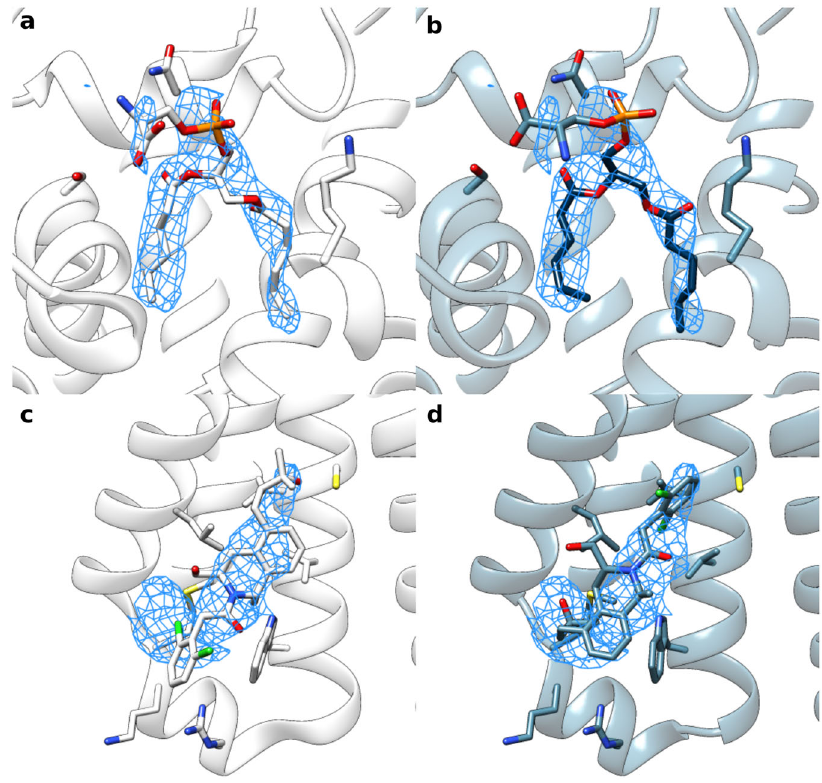
fi nd the same lipid tail orientations (dark blue). c The deposited model of LY3154207bound to DRD1 (EMDB: 30395, PDB: 7CKZ, localresolution: 3.09Å) and EMERALD-docked model ( d ) adopt different conformations. With low-resolution density and few residue binding partners, both models are equally